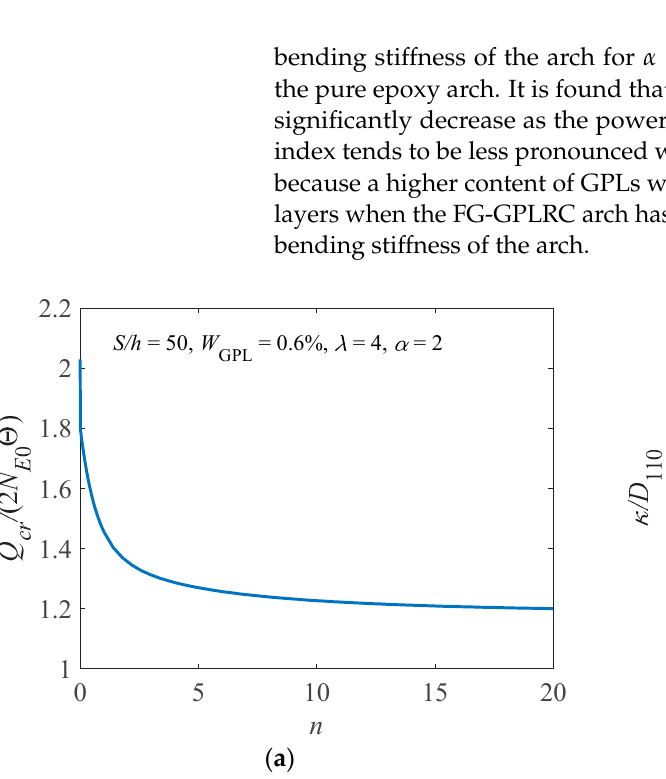
Figure 5. Effect of the power law index on ( a ) the buckling load and ( b ) the effective bending stiffness.